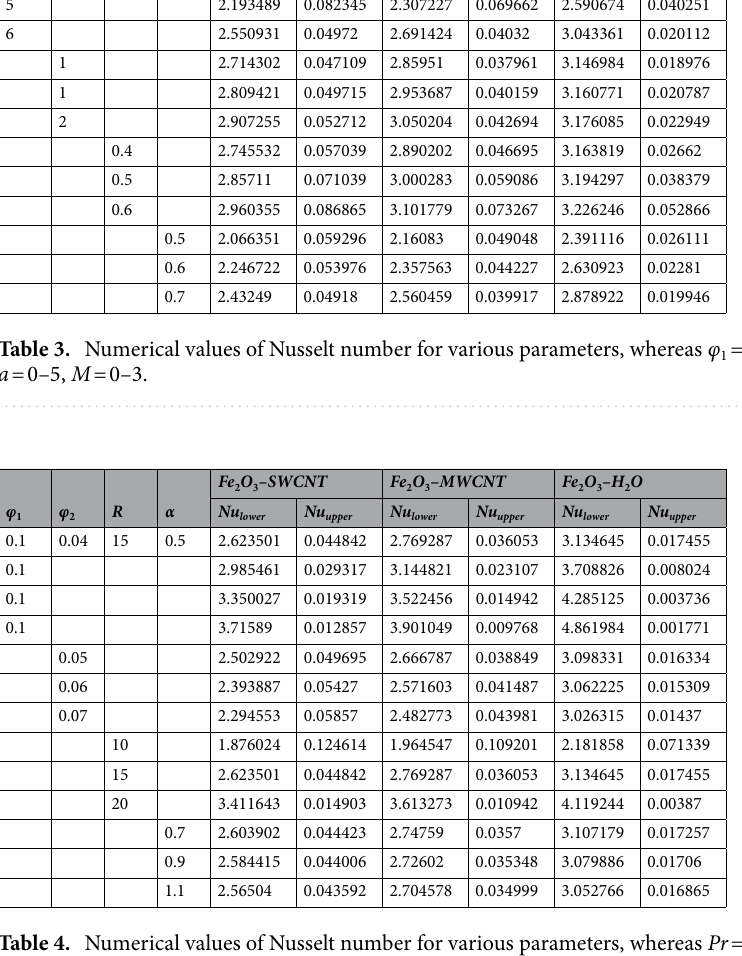
Table 4. Numerical values of Nusselt number for various parameters, whereas Pr = 6–2, Tr = 1–7, Rd = 0–3, A =